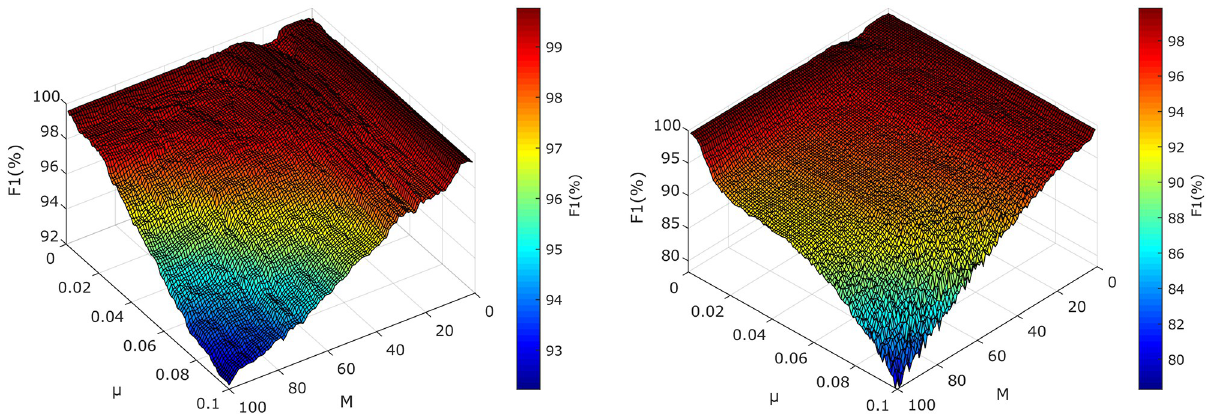
Fig 5. Comparison of the results of LMS-based systems for recording r01, μ 2 (0, 0.1), M 2 (0, 100). From left to right: a) System using Standard LMS algorithm; b) System using Sign Error LMS algorithm.